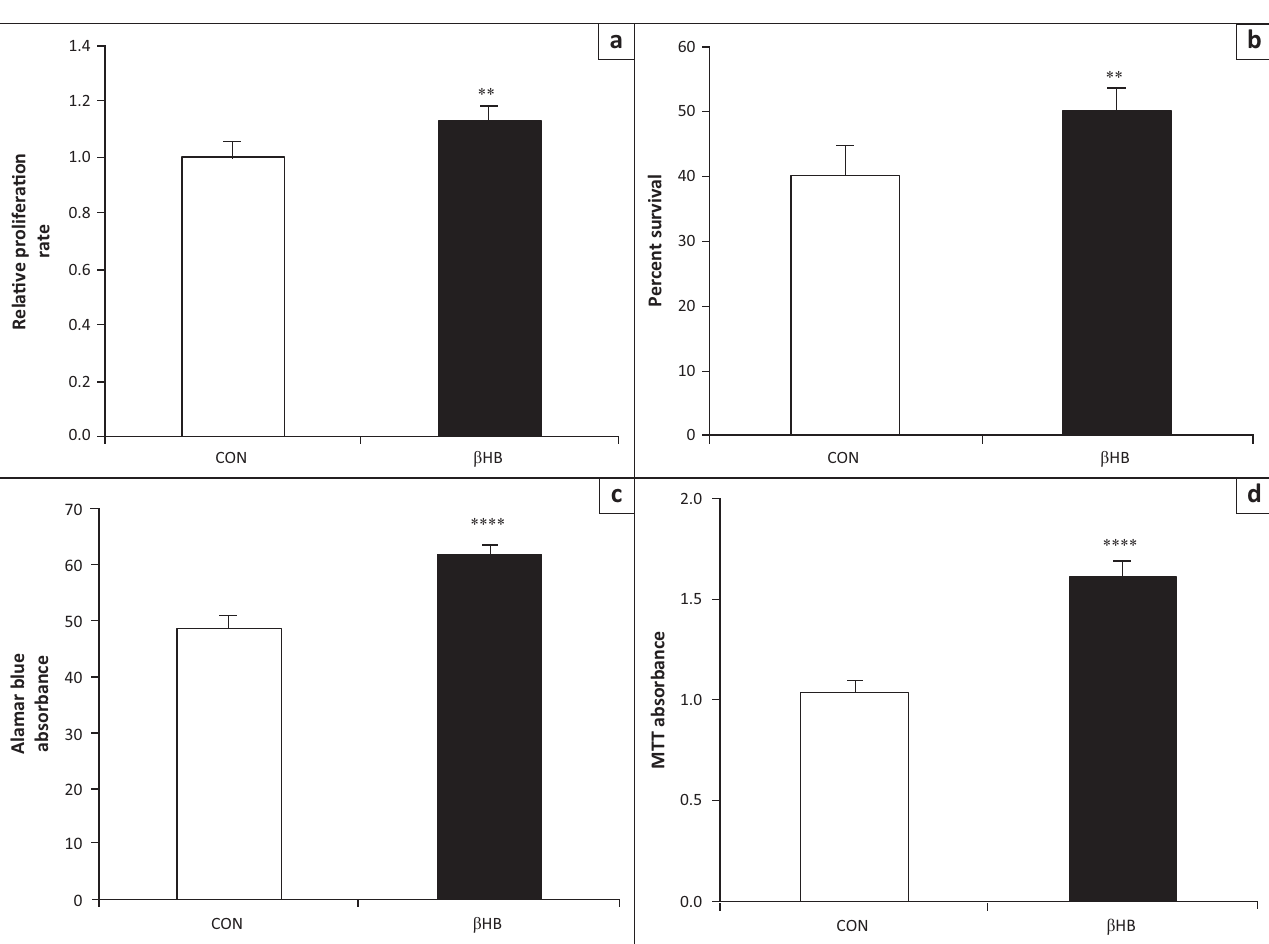
FIGURE 1: β -Hydroxybutyrate increases INS-1 832/13 β -cell replication and maintains cell survival rate. (a; n = 6) INS-1 832/13 β -cells proliferation rate was calculated by counting cells following 48 h of culture with vehicle (water; CON) or 10 mM β -Hydroxybutyrate ( β HB), measured for viability after treatment with 1 mM Palmitate for the final 24 h of culture (b; n = 6), stained with Alamar Blue (c; n = 6), or with MTT (d; n = 6) to determine metabolic activity. ** P < 0.01 for β HB versus CON. **** P < 0.0001 for β HB versus